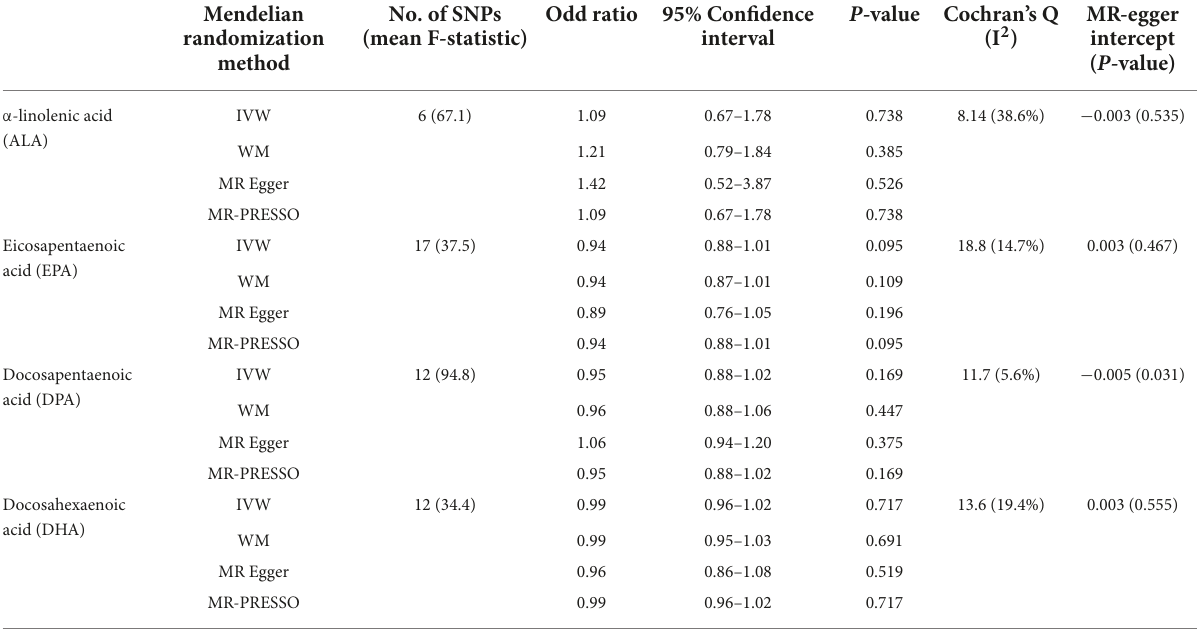
TABLE 1 Mendelian randomization (MR) estimates of causality between plasma omega-3 polyunsaturated fatty acids (PUFAs) and sleep apnea (SA).